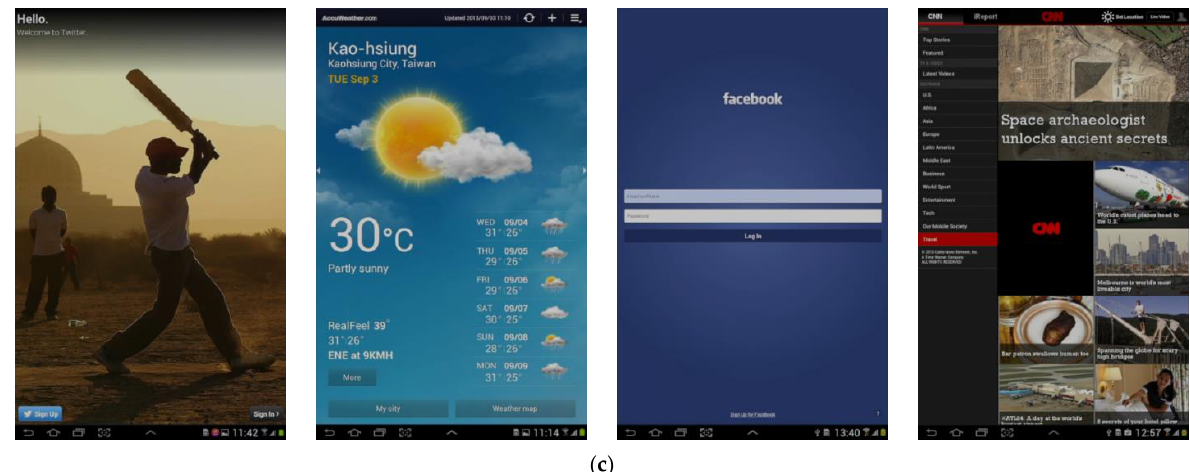
Figure 12. Comparison of CURA and the proposed method: ( a ) original image, ( b ) CURA, ( c ) proposed method.